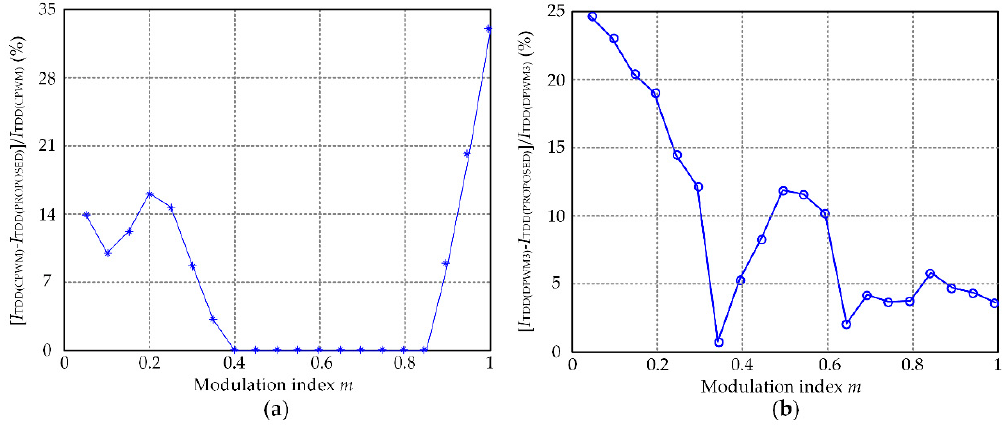
Figure 12. The percentage improvement of proposed method versus CPWM and DPWM3: ( a ) proposed strategy versus CPWM ( b ) proposed strategy versus DPWM3.